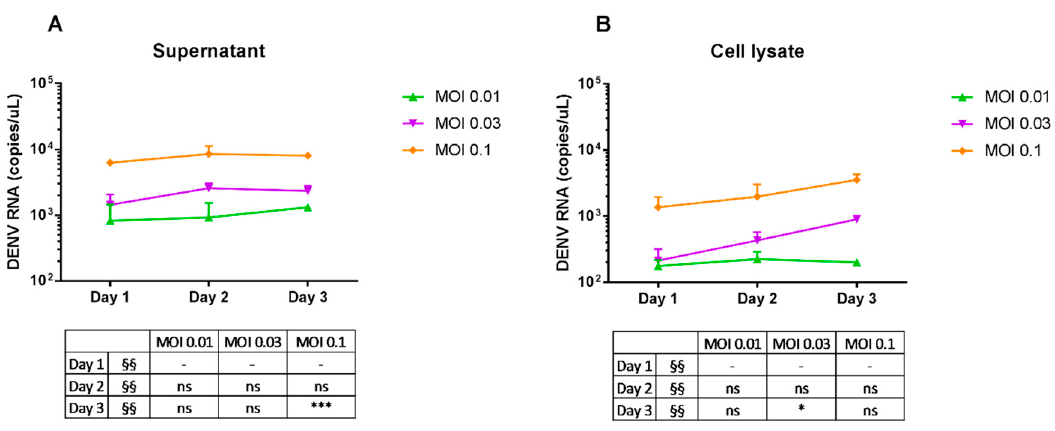
Figure 3. Dengue virus RNA replication in THP-1 cells. Cells were mock-infected or infected with DENV-3 at varying doses, incubated, and harvested after 1, 2 and 3 days post-infection. Total RNA from culture supernatant and cell lysates was extracted and reverse transcription quantitative real-time PCR was used to determine the expression of dengue virus mRNAs. Viral genome copy numbers in the supernatant ( A ) and cells ( B ) were estimated using dengue virus RNA as standards. Unpaired t -test was used to calculate significance (ns = no significance, * p ≤ 0.05 and *** p ≤ 0.001) vs. Day 1. §§ represents time-dependent variable.